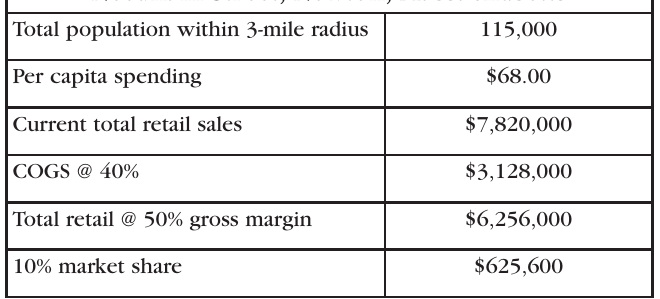
Table 4. Potential Volume for Retail Flower Store on Needham Street, Newton,